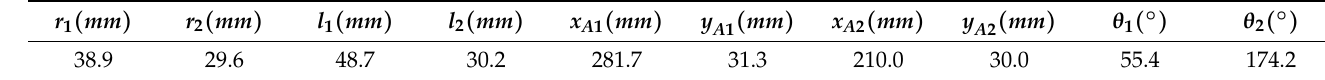
Table 2. Values of the design variables for the chosen design (design B).